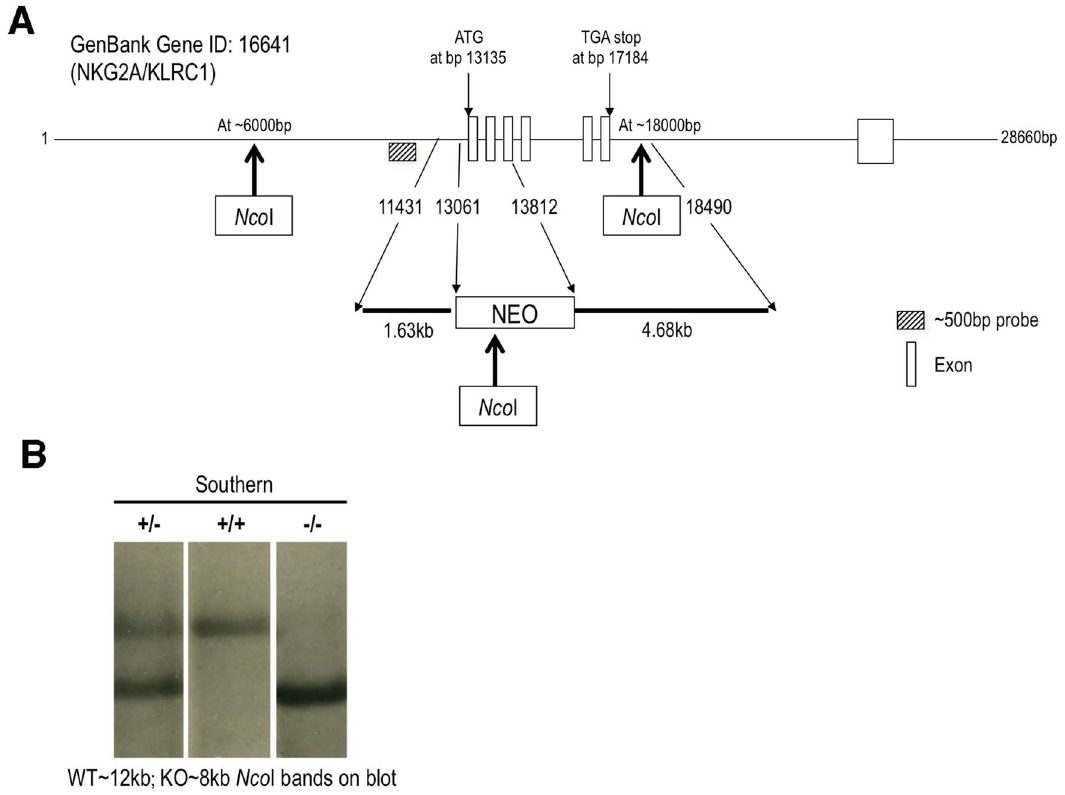
Figure 3. NKG2A gene knockout schema and Southern Blot. A. Schematic of the KLRC1 (NKG2A) gene showing the region of substitution of Neo cassette and the location of NcoI digestion sites used in generating gene fragments for southern blot for confirmation of the knockout genotype. B. Genotyping of NKG2A 2 / 2 by southern blot. Lane 1 shows both WT (12 kb) and NKG2A 2 / 2 (8 kb) NcoI digest fragments in heterogeneous mice, lane 2 homozygous WT (12 kb) band and lane 3 homozygous NKG2A 2 / 2 (8 kb). The probe sequence is provided as Figure S1.